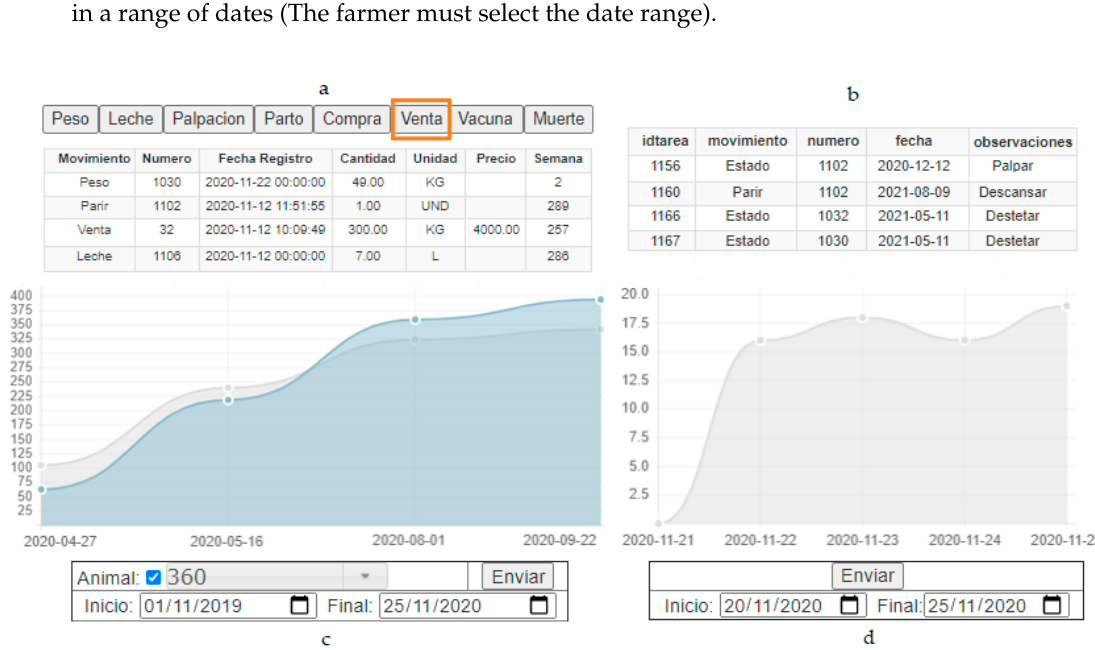
Figure 5. Example of the DSS options: events report, forecast list, Graphical report on individual production and graphical report on consolidated production (milk).